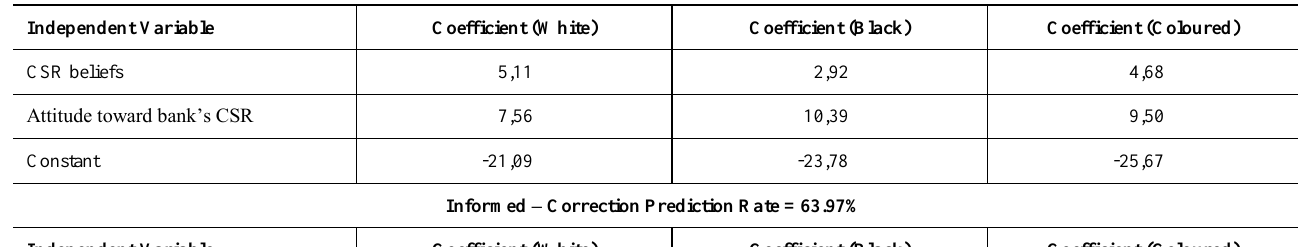
Table 8: Discriminant analysis across race Uninformed – Correction Prediction Rate =